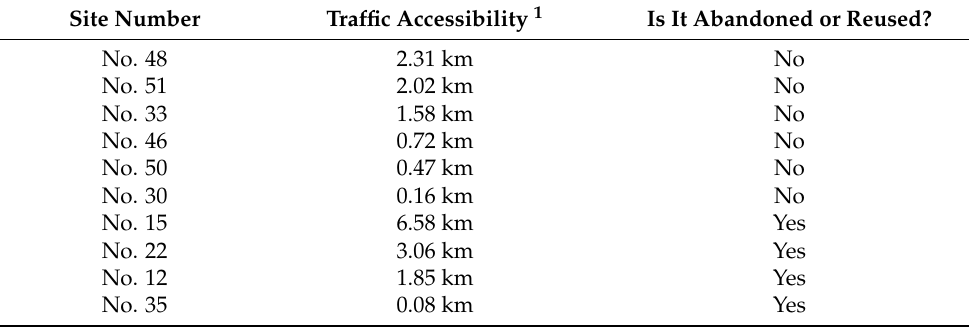
Table 4. Statistics of accessibility analysis of resource-intensive industrial heritage.